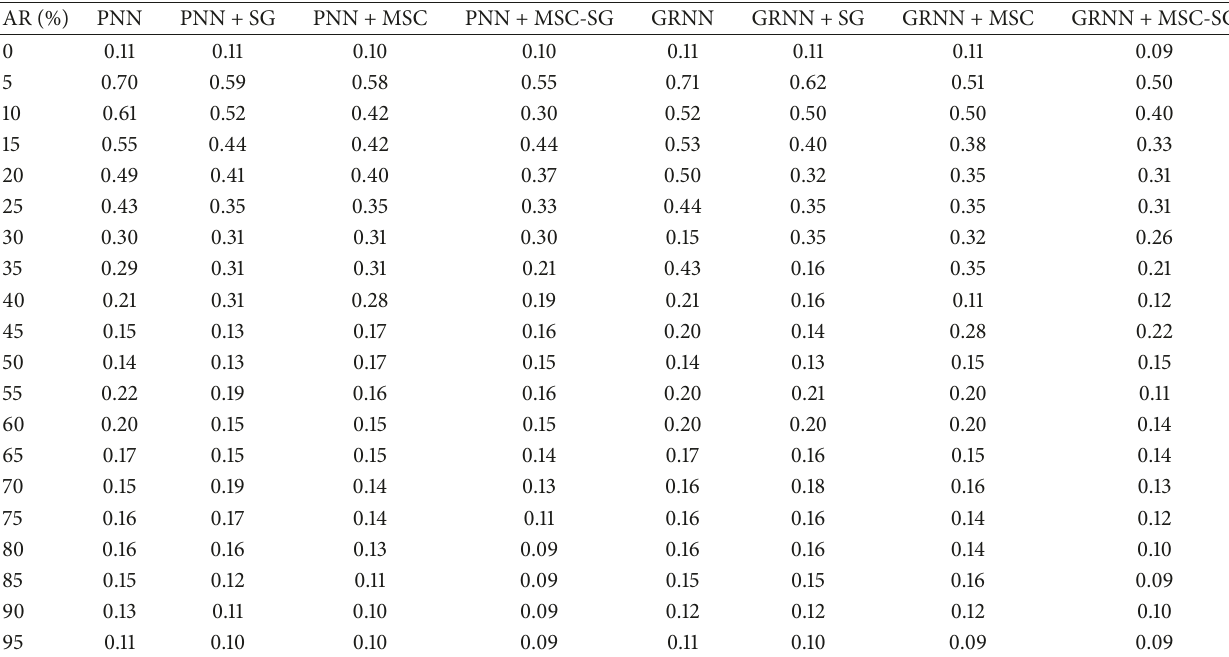
Table 2: RMSE of prediction set at different AR.